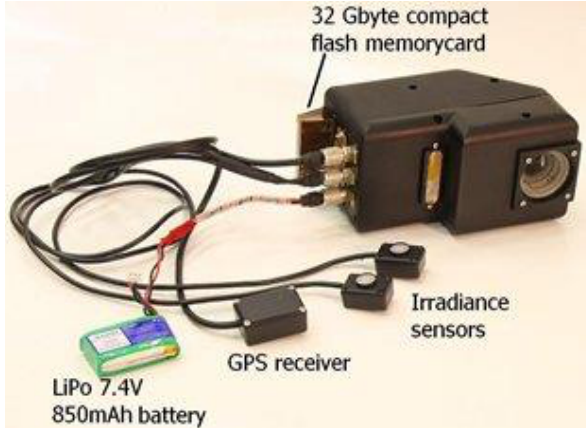
Figure 1. The FPI spectral